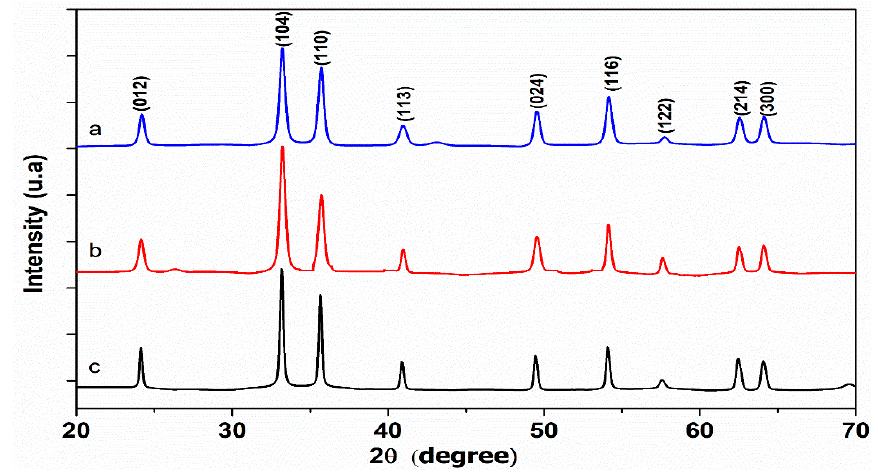
Figure 3. X-ray diffraction (XRD) patterns of ( a ) Fe 2 O 3 , ( b ), Fe 2 O 3 -CMS and ( c ) CMS. Figure 3. X-ray di ff raction (XRD) patterns of ( a ) Fe 2 O 3 , ( b ), Fe 2 O 3 -CMS and ( c )